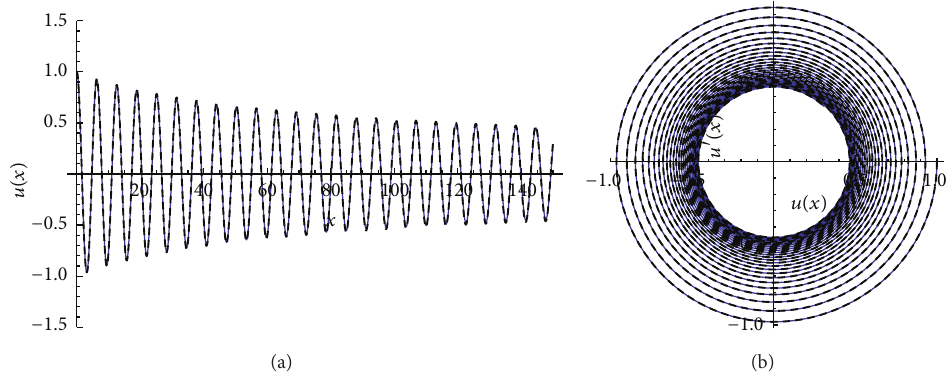
Figure 2: (a) Plots of displacement of 𝑢 versus time. (b) Phase plane diagram of Example 2: solid line the multistep RKHS method and dotted line RK method.